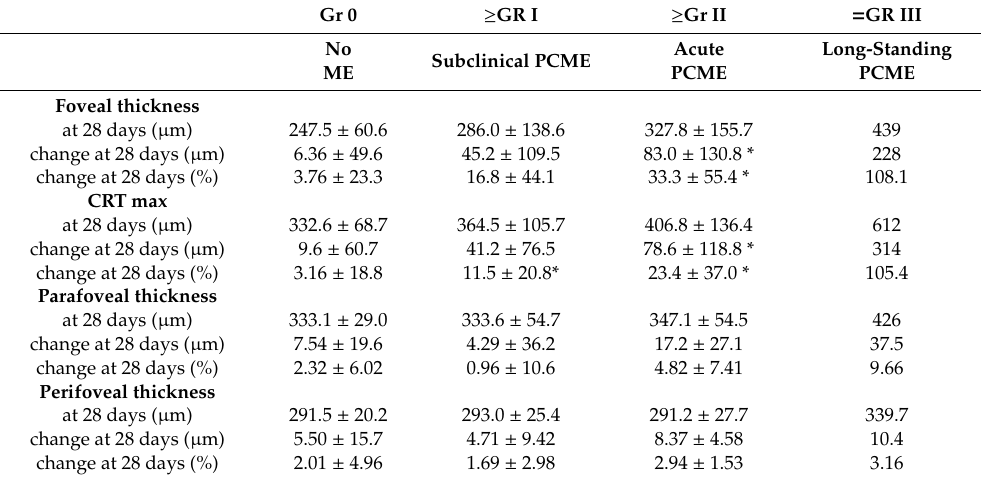
Table 4. Macular thickness parameters.